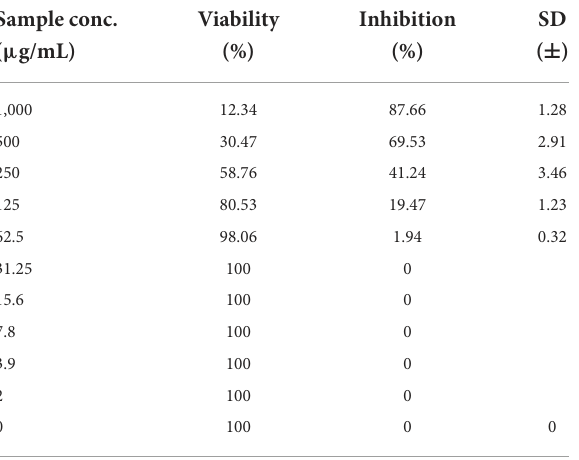
TABLE 2 Cytotoxic activity of propolis in mammalian cells derived from African Green Monkey kidney (Vero) cells at a 50% cell cytotoxic